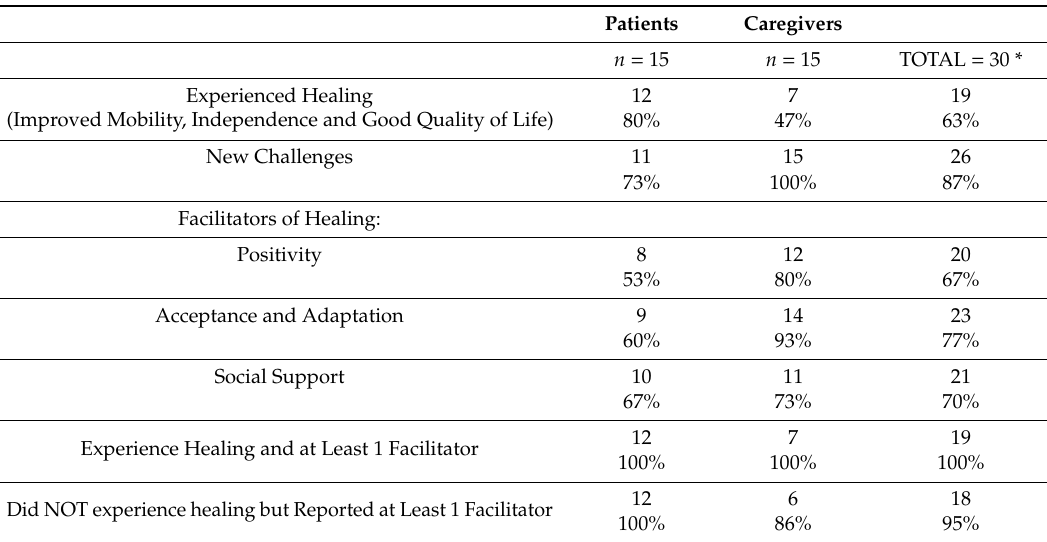
Table 3. Variables of su ff ering and healing